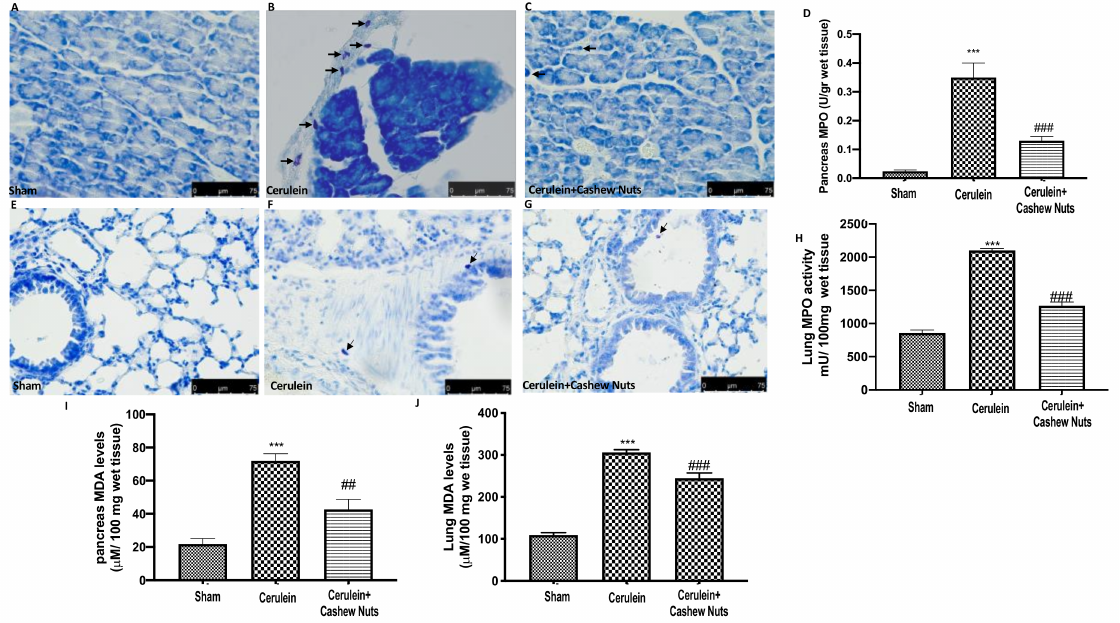
Figure 2. E ff ects of cashew nuts on cerulein-induced mast cell degranulation and MPO and MDA activity. Pancreas: ( A ) sham, ( B ) cerulein, ( C ) cerulein + cashew nuts, ( D ) MPO and ( I ) MDA. Lung: ( E ) sham, ( F ) Cerulein, ( G ) cerulein + cashew nuts, ( H ) MPO and ( J ) MDA. Arrows indicate mast cells. Values shown are means ± SEM of 6 mice. *** p < 0.001 vs. sham; ## p < 0.01 vs. cerulein; ### p < 0.001 vs.